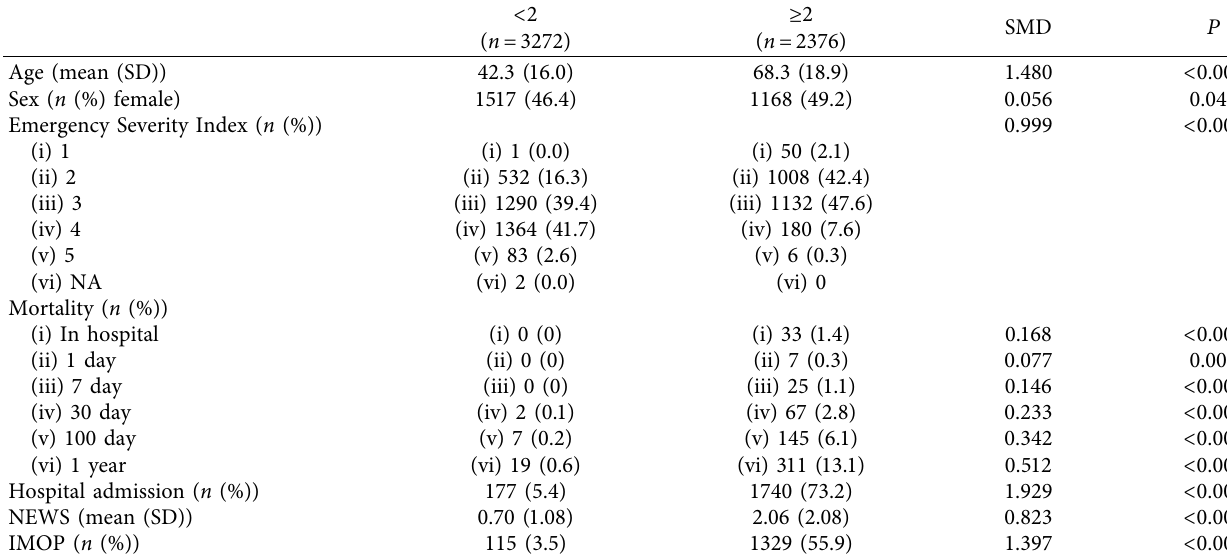
Table 2: Demographics of patients stratified by the SPS of ≥ 2. Data are shown as mean and SD for continuous variables and as count and percentage for categorical variables.